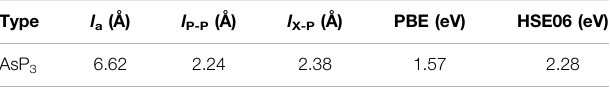
TABLE 2 | Calculated elastic modulus C 2 D (J m − 2 ), DP constant E l (eV), effective mass m *